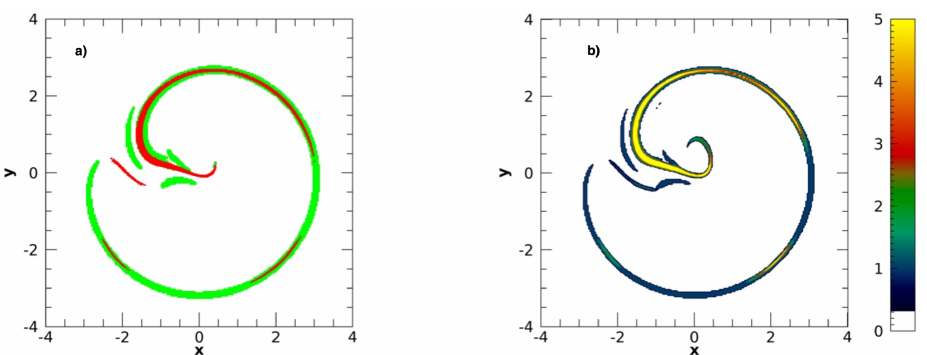
Figure 7. ( a ) The positions of the particles in a transverse section of the jet, in green the particles that have an age less than r j / c (still not cooled and, hence, assumed to emit high-energy radiation) and in red the particles that have an age between 3 r j / c and 10 r j / c (cooled, emitting in the optical). ( b ) Plot of the the density of particles in the same section of the jet. The panels refer to the time at which the dissipation is maximal. From [68]. Reproduced with kind permission from Oxford University Press and the Royal Astronomical